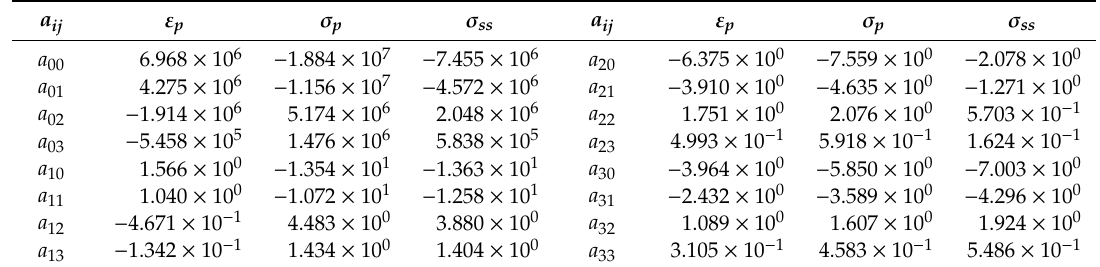
Table 5. Material constants of the multivariate-polynomial based